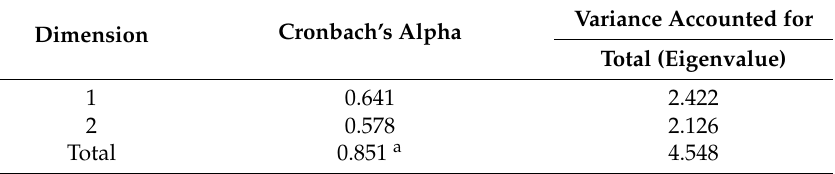
Table A1. CATPCA (model summary).